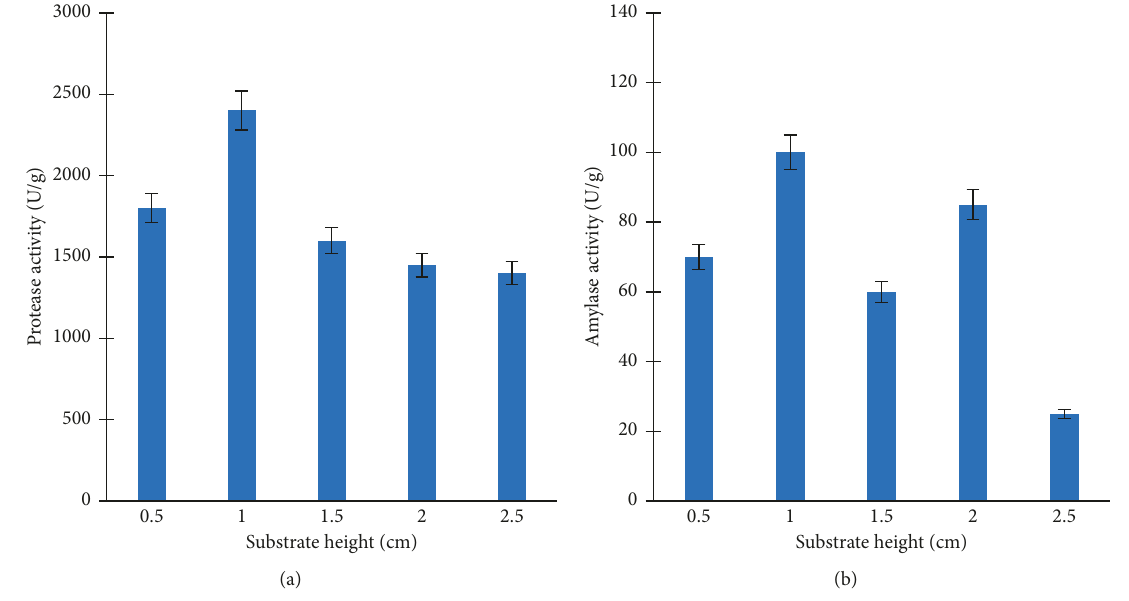
Figure 6: Effect of substrate height on protease activity (a) and amylase activity